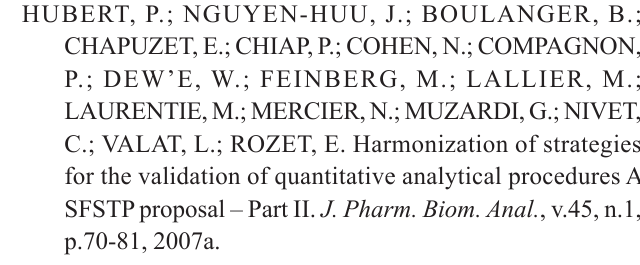
TABLE III - Potency data obtained in analysis of raw material gramicidin using microbiological assay of diffusion on plates